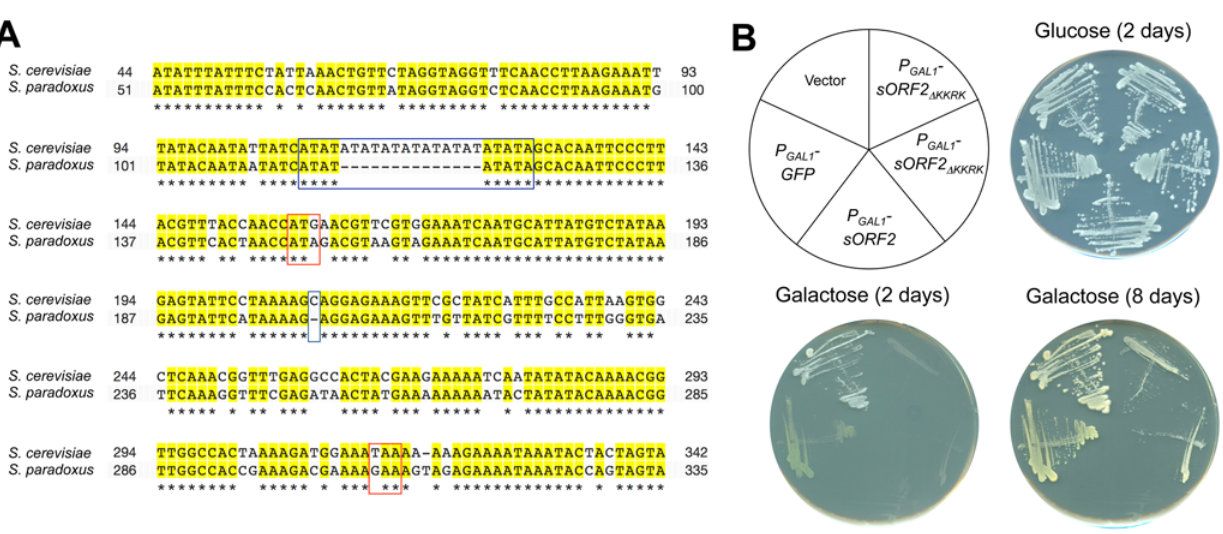
Fig 4. Structural analysis of sORF2. A. Alignment of the sORF2 regions of S . cerevisiae and S . paradoxus . Identical nucleotides are shown in yellow. ATG and STOP codons of sORF2 are shown in red. A TATA repeat and deletion in the S . paradoxus sequence are indicated in blue. The image is a snapshot from the fungal sequence align- ment of SGD (http://www.yeastgenome.org/cache/fungi/YGR229C.html). The nucleotide numbers indicate the positions relative to the stop codon of SMI1 . B. Overexpression of sORF2 without the potential NLS (sORF2 Δ KKRK ). The construct used in this experiment is shown. Cells with pTOW-P GAL1 -sORF2 ( P GAL1 -sORF2 ) or pTOW-P GAL1 -sORF2 Δ KKRK ( P GAL1 -sORF2 Δ KKRK ) were streaked onto SC-glucose and SC-galactose plates and incubated for